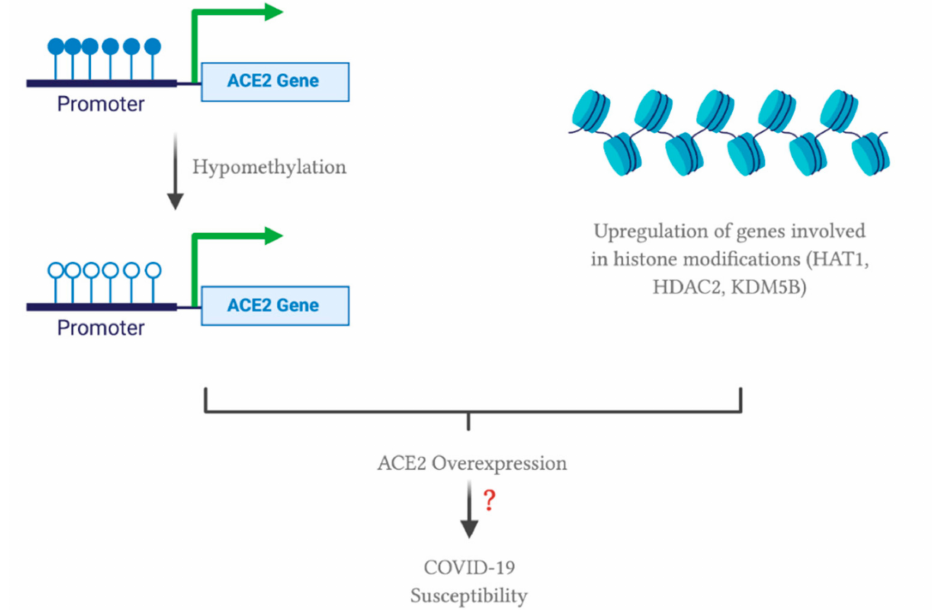
Figure 1. Possible effect of comorbidities on epigenetic regulation of angiotensin converting enzyme 2 (ACE2). All of the figures were created with